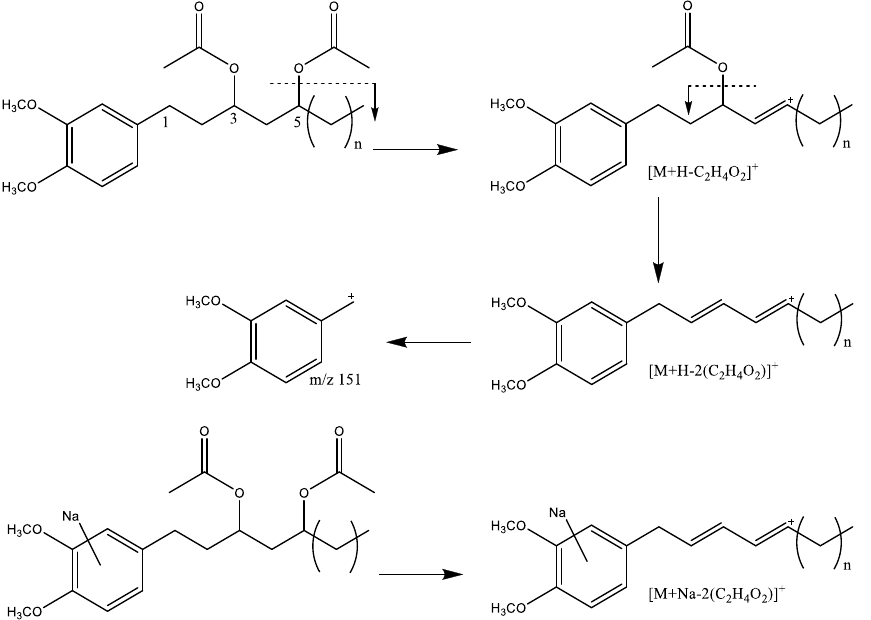
Figure 11. Fragmentation pathway for methyl-diacetoxy-gingerdiol compounds 15 ( n = 4), 24 ( n = 6), 31 ( n = 8), 33 ( n = 10). 31 ( n = 8), 33 ( n =